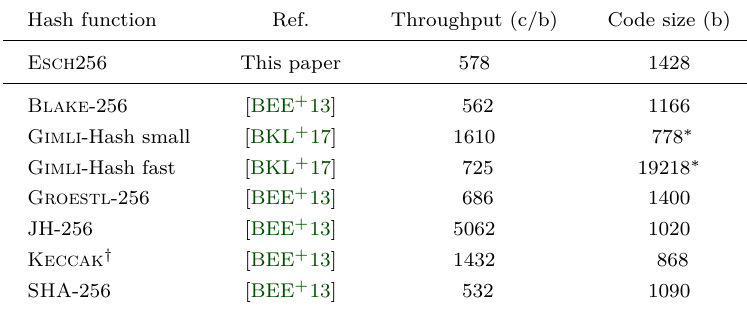
Table 15: Comparison of Esch 256 with other hash functions producing a 256-bit digest. The number of cycles and the throughput were obtained by hashing a 500-byte message on an AVR microcontroller. The implementation of Esch 256 contains hand-optimized assembler code only for the permutation, whereas the implementations of all other hash functions were written entirely in assembler. Hash function